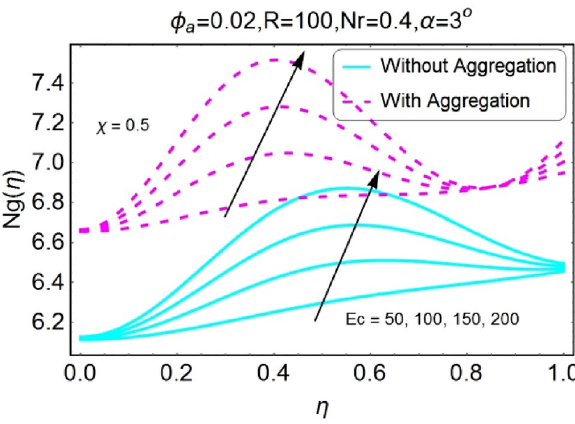
Figure 38. Ec varying Ng for stretching walls (divergent channel).